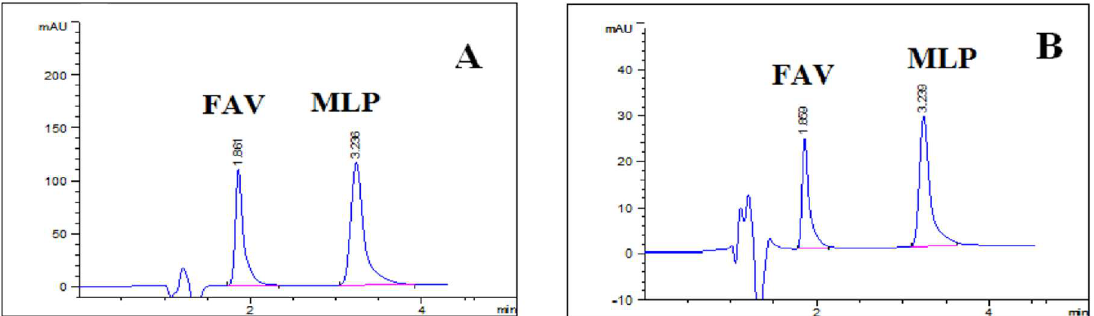
Figure 5. Chromatogram showing separation of drugs under study in ( A ) QC standard (25 µg mL −1 ) and ( B ) combined Epifluvir ® /Molcovir ® dissolution testing under the proposed chromatographic conditions.